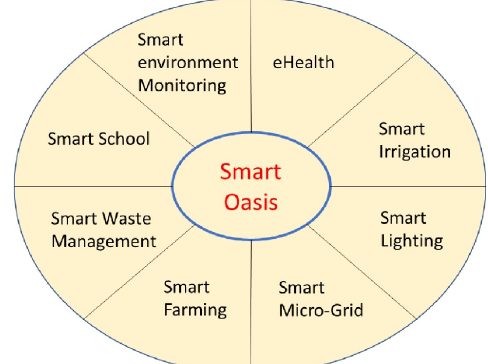
Figure 3 . Ensemble of Smart Applications to build the Smart